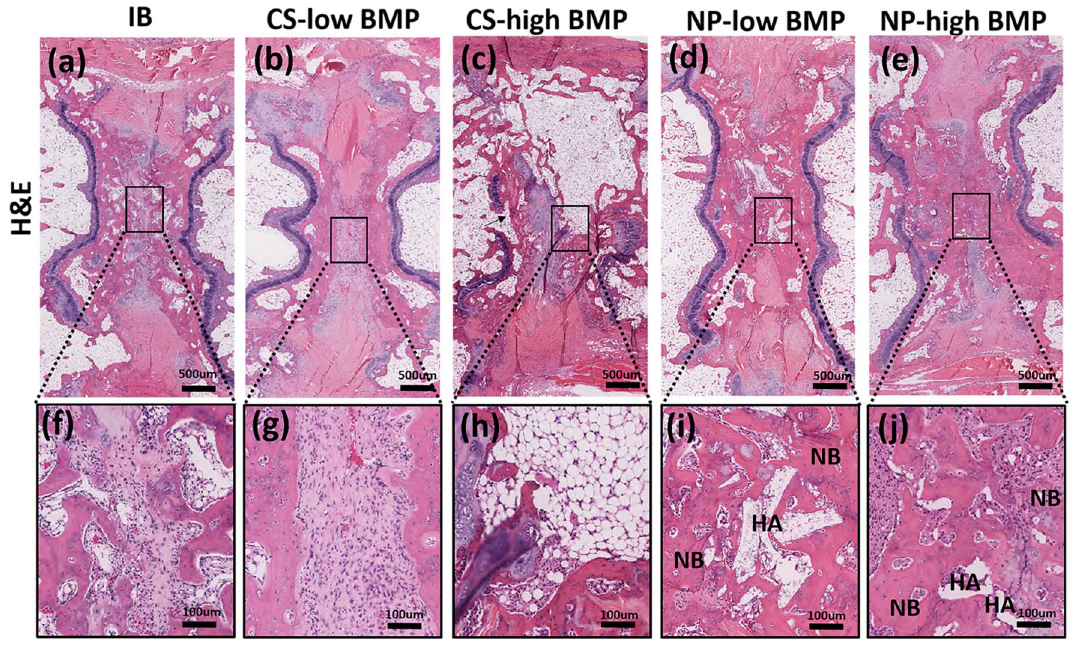
Figure 5. Histological images of treated segments at 6 weeks postoperation. Hematoxylin & eosin (H&E) staining of treated segments. Whole intervertebral disc space ( a – e ), Magnified central parts of the disc space ( f – j ). Fibrous tissue was present between adjacent endplates in the IB group ( a , f ) and in the CS-low BMP group ( b , g ). In the CS-high group, new bone formation that bridged the endplates was observed, but the new bone was predominantly composed of adipose tissue ( c , h ). Thick trabecular bone formation between the endplates was observed in both the NP groups ( d , e ). A small amount of HA granules remained inside the newly formed bone ( i , j ). NB, new bone; HA, hydroxyapatite.